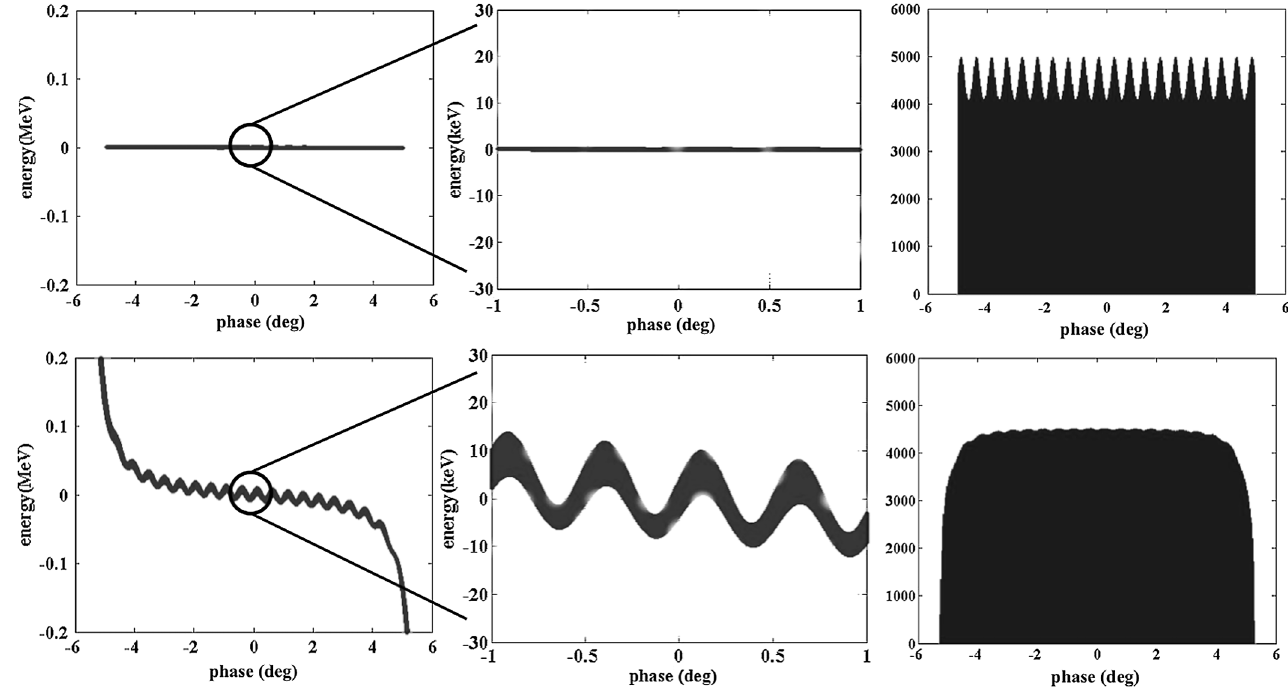
FIG. 7. Longitudinal phase space (left and center pictures) and bunch current distribution at the entrance of the leading drift (upper pictures) and entrance of the rf structure located 0.6 m downstream (lower pictures). The wavelength of the initial density modulation is (cid:5) ¼ 150 (cid:12) m . The longitudinal space coordinate is expressed in terms of rf phase with 10 deg rf phase corresponding to about 3